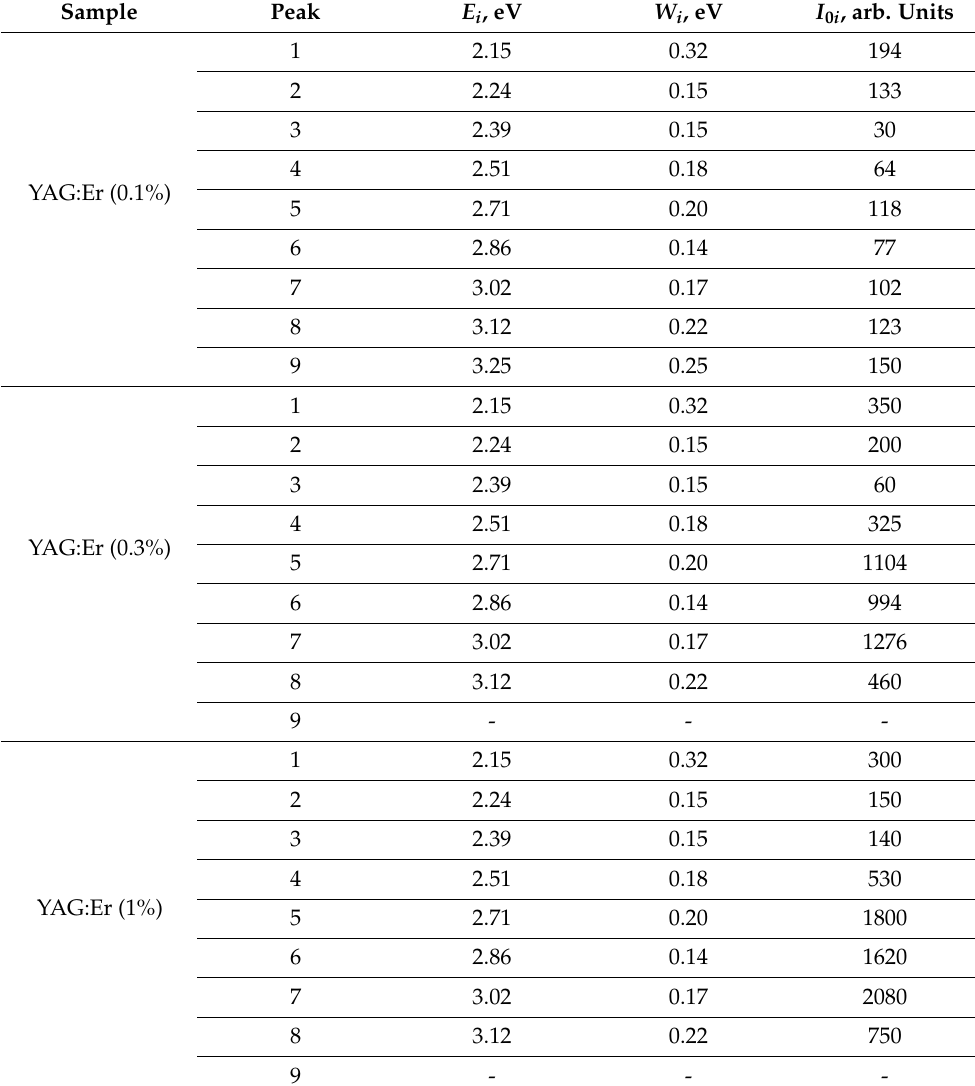
Table 3. Fit parameters from Equation (4). The error of E i and W i ( i = 1–9) determination is ± 0.03 eV. The error of the I 0 i ( i = 1–9) determination is ± 3 arb. units.